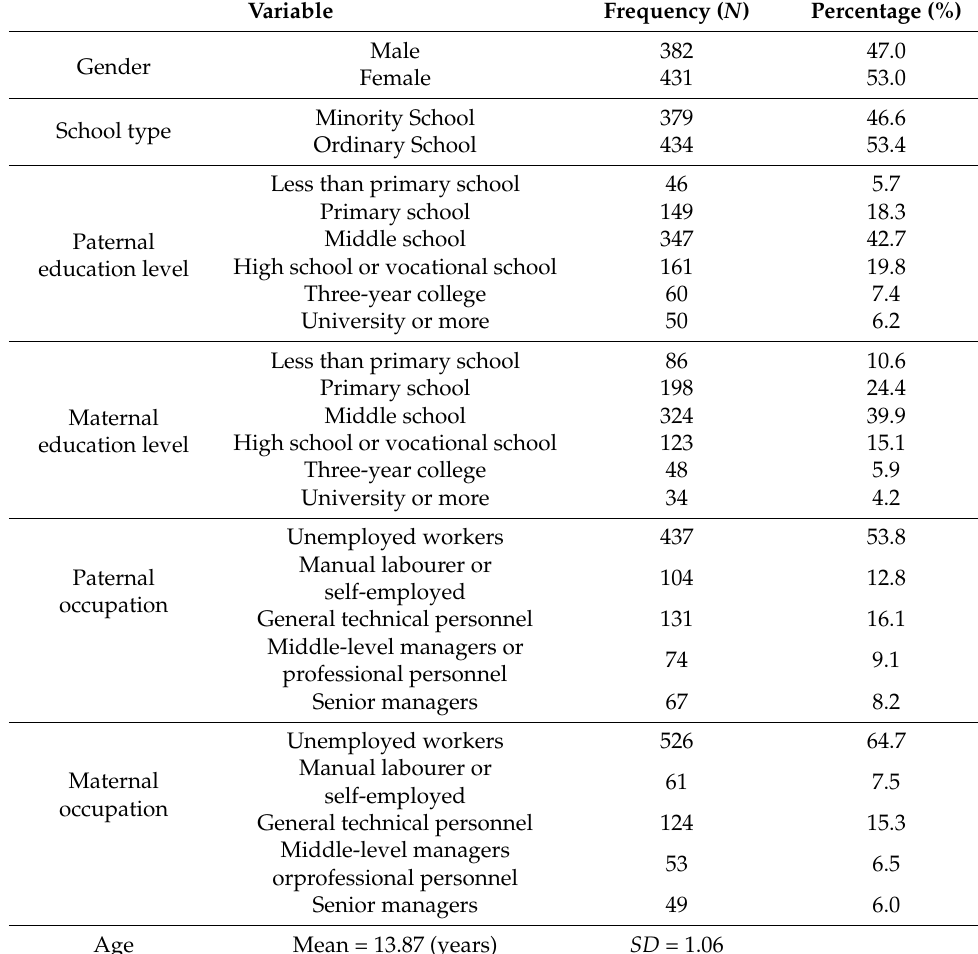
Table 1. Demographic information of participants ( N =